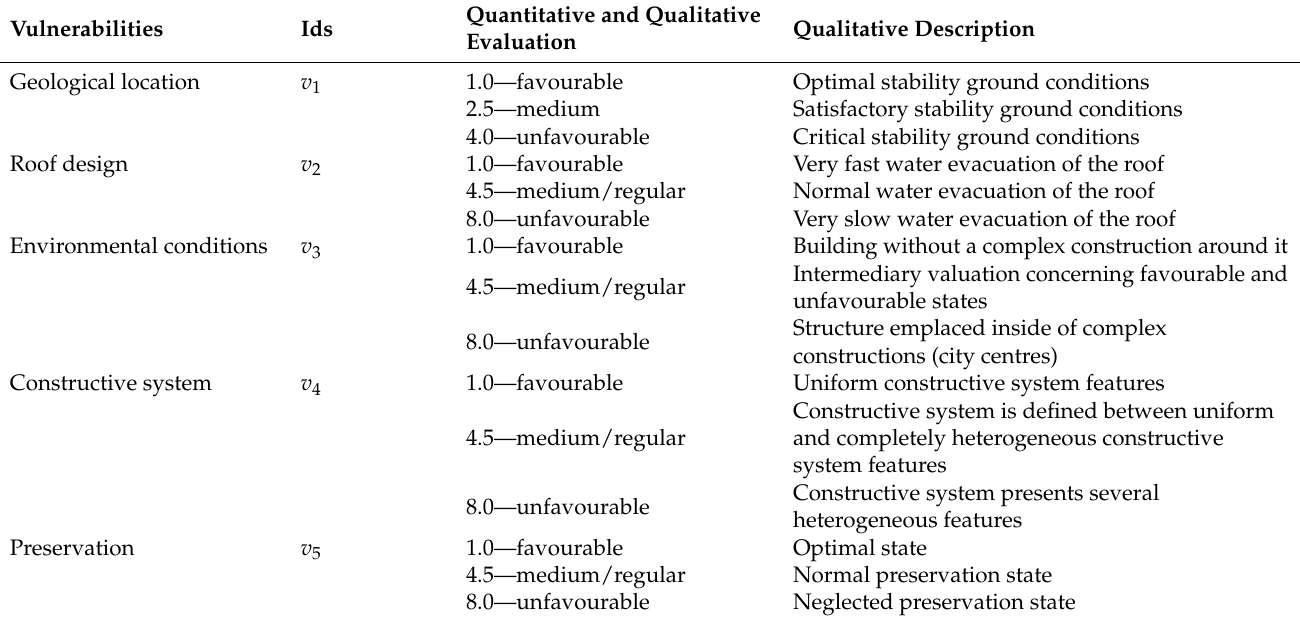
Table 2. Input variable descriptions related to buildings’ vulnerabilities [36].